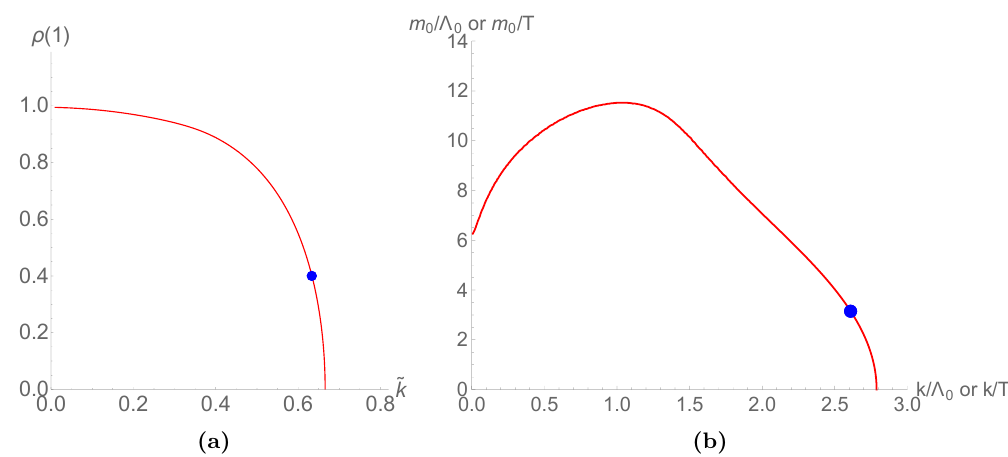
Figure 5. The solution line with (cid:17) = 1. The numerical solution corresponding to the blue dot in the (cid:12)gures is depicted in (cid:12)gure 1. Here we took w 0 (1) = w 1 (1) = 10 (cid:0) 4